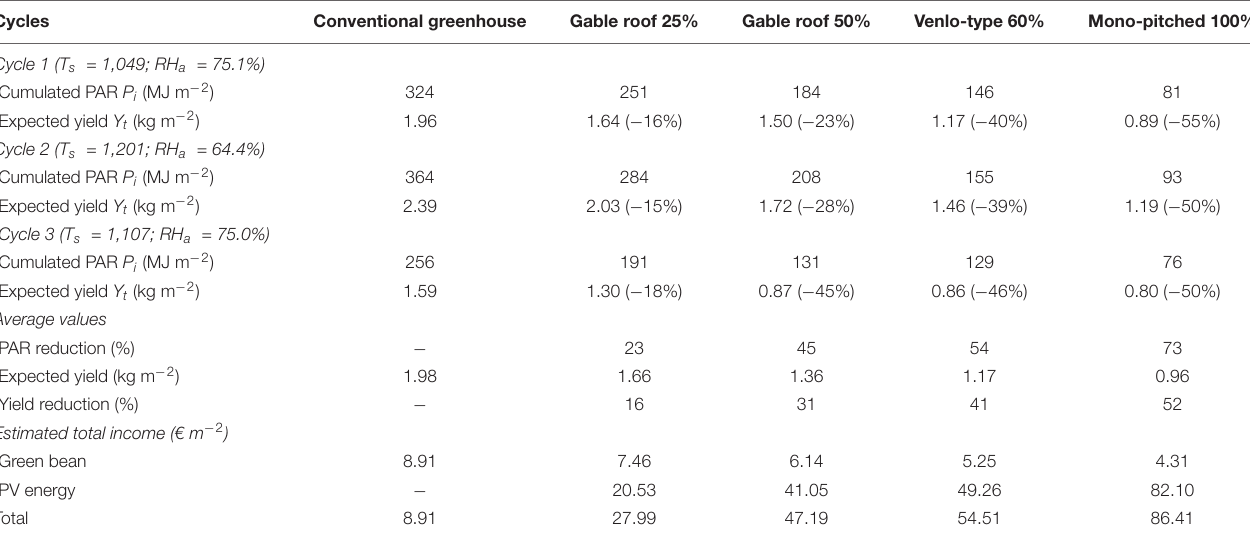
TABLE 2 | Expected average green bean yield in the four photovoltaic greenhouse (PVG) types with photovoltaic cover ratio ( PV R ) ranging from 25 to 100%. Cycles Conventional greenhouse Gable roof 25% Gable roof 50% Venlo-type 60% Mono-pitched